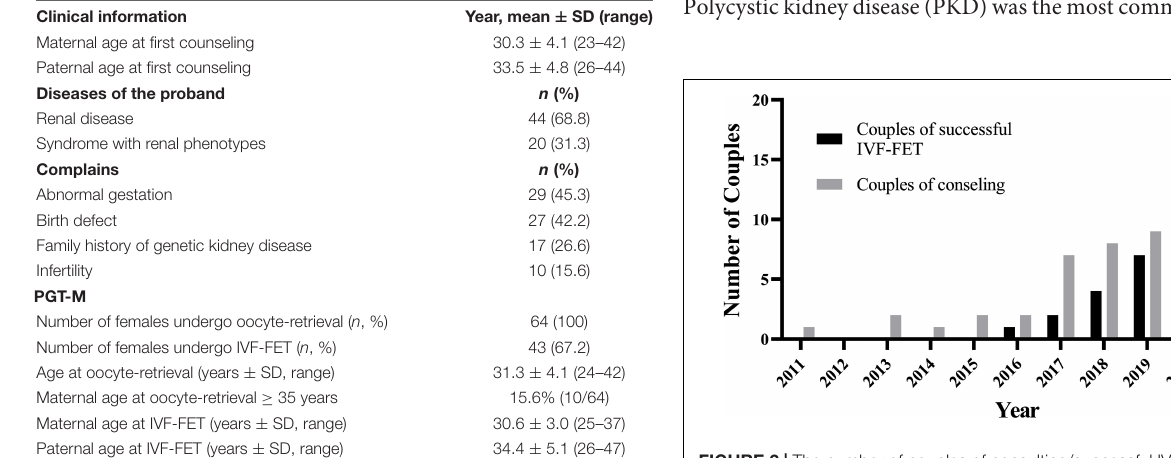
FIGURE 2 | The number of couples of consulting/successful IVF-FET has grown since 2018 in one medical center. IVF-FET, in vitro fertilization and frozen-embryo